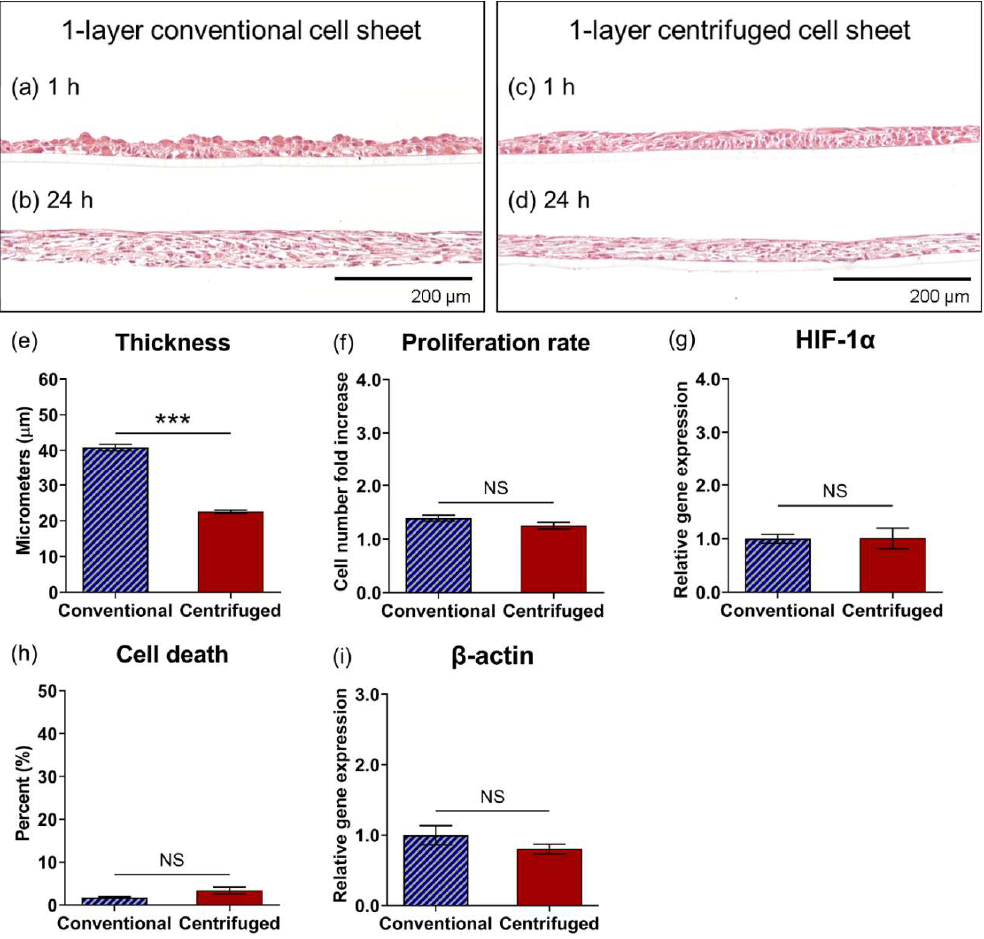
Figure 3. Centrifugation compacts cell sheet tissue structure. Histological cross-sections of conventional and centrifuged 1-layer cell sheets stained with H&E at ( a , c ) 1 h and ( b , d ) 24 h after fabrication, with quantified comparisons for 1-layer conventional and 1-layer centrifuged cell sheets ( e ) tissue thickness, ( f ) cell proliferation rate, ( g ) HIF-1α gene expression, ( h ) non-viable cell ratio, and ( i ) β-actin gene expression in 24-h samples. Gene expression is normalized to GAPDH and compared to the 1-layer conventional cell sheet. Scale bars = 200 μm. Values are means ± SE (*** p < 0.001). NS = not significant ( p > 0.05).